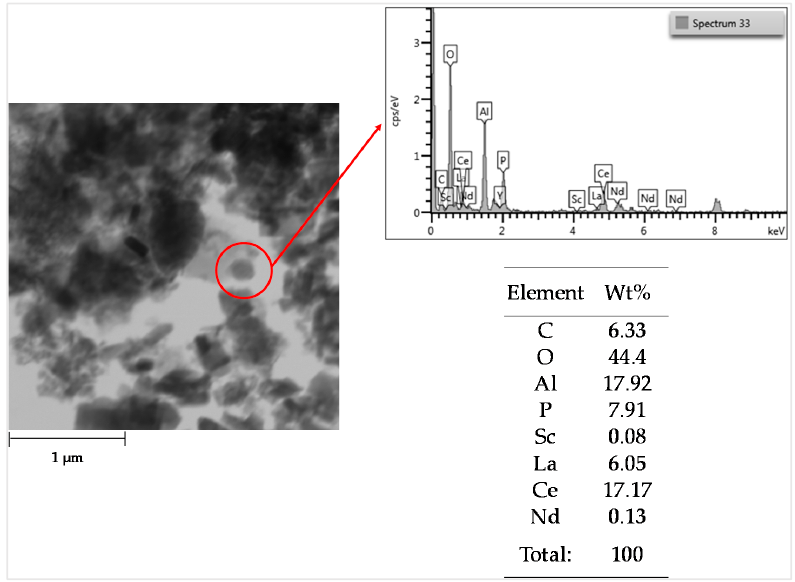
Figure 10. TEM image of a CePO 4 , Al containing, particle.